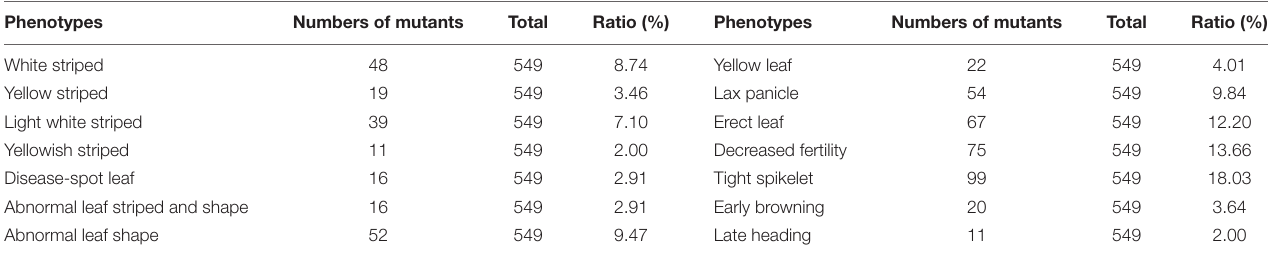
TABLE 1 | Phenotypes of 549 mutants after a preliminary